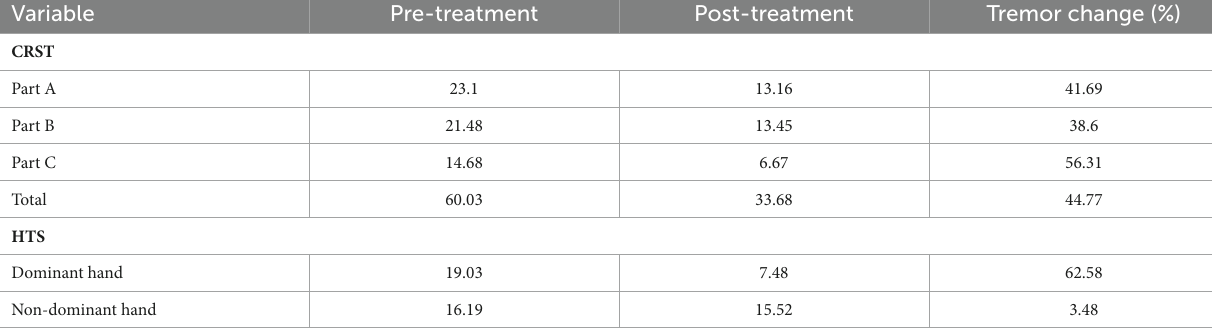
TABLE 2 Mean change in tremor scores between pre-treatment and the most recent clinical visit following treatment with